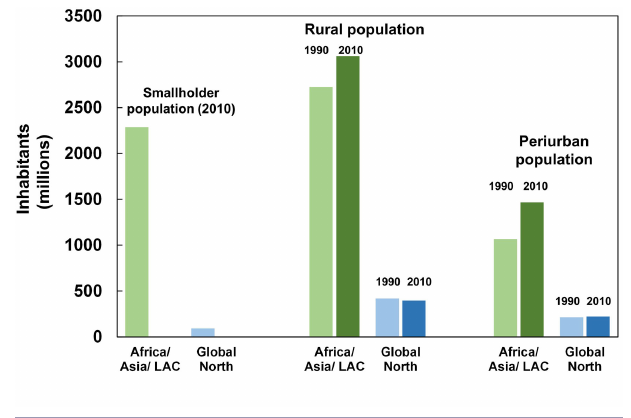
Fig. 1 . Principal geographic distribution of global smallholder populations (2010) with comparisons to global rural and periurban populations (1990, 2010; LAC refers to Latin America and the Caribbean. The Global North includes Australia, Canada, Europe, New Zealand, and the United States. Methods: Smallholder and rural populations were estimated using major data sources on global population (HLPE 2013, World Bank 2014). The HLPE uses the definition of smallholders as agricultural land users with holdings smaller than 2 hectares. Periurban populations were estimated by calculating using GIS buffer layers of radius set in direct proportion to the city population and the gridded global population (SEDAC gridded population of the world, V.3;